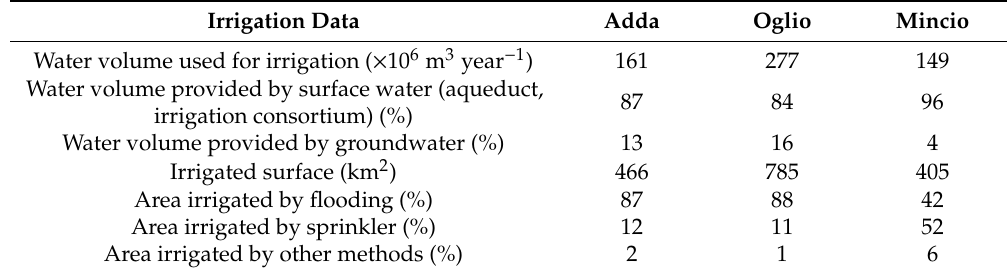
Table 3. Summary of irrigation practices in the portions of three basins (Adda, Oglio, and Mincio) object of this study. Data source: [62].